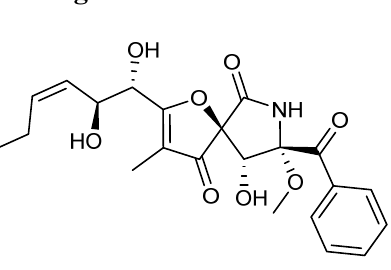
Figure 23. Pseurotin